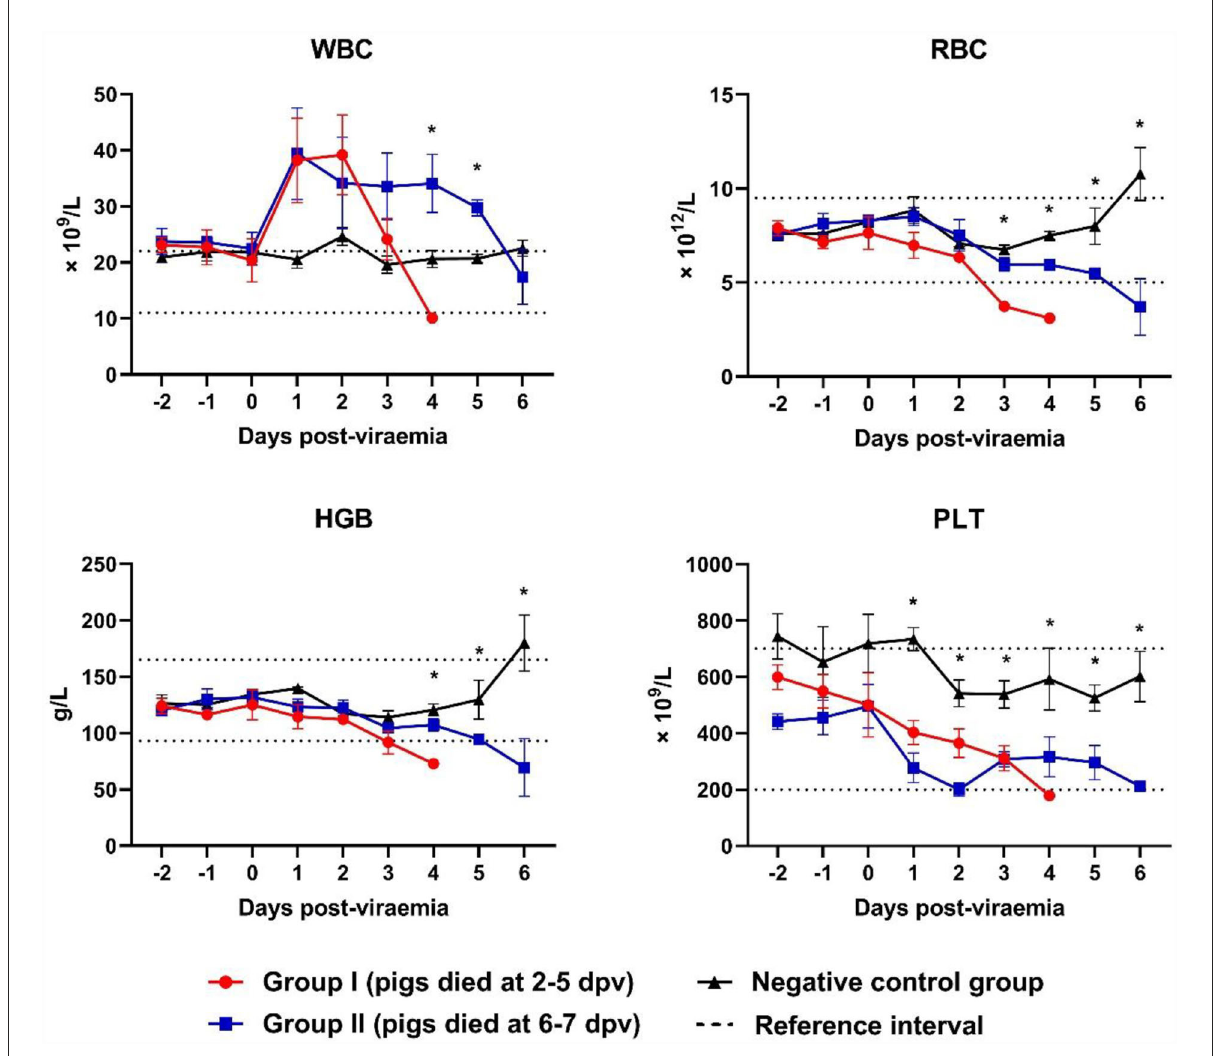
FIGURE3 Blood counts during infection. * p < 0.05. WBC, white blood cell, RBC, red blood cell; HGB, hemoglobin; PLT, platelet. The reference intervals of each blood parameter are represented as dotted